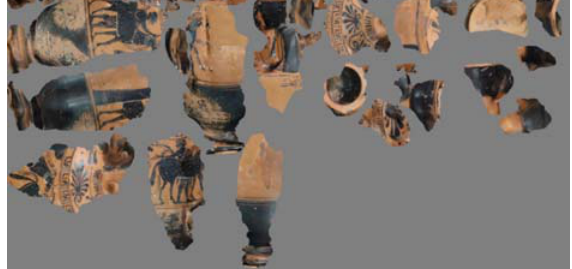
Fig. 13. Texture map of the bigger lekythos, as it is derived from the 123catch software